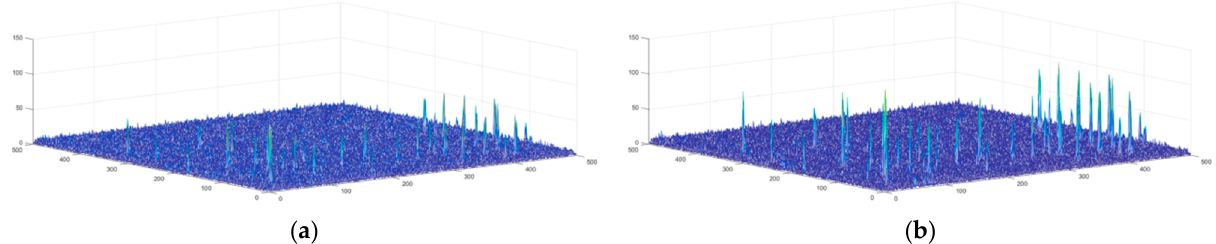
Figure 3. Comparison of the contrast saliency maps of GF-4 image: ( a ) result generated by conven- tional lateral inhibition network; ( b ) result by ours with protection domain.